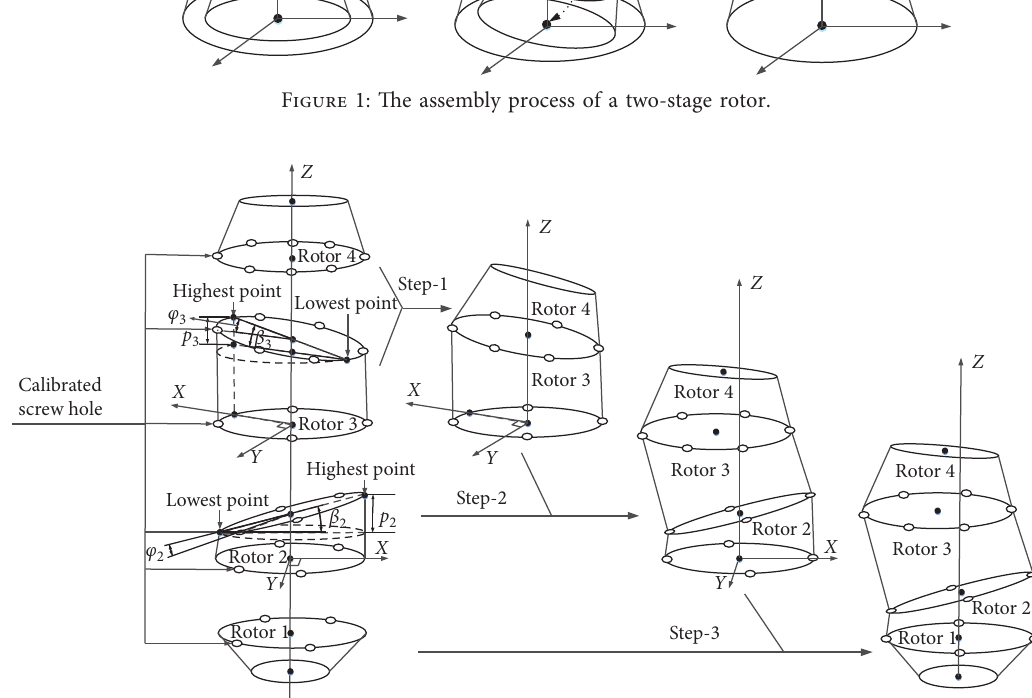
Figure 2: The descending assembly process of a four-stage